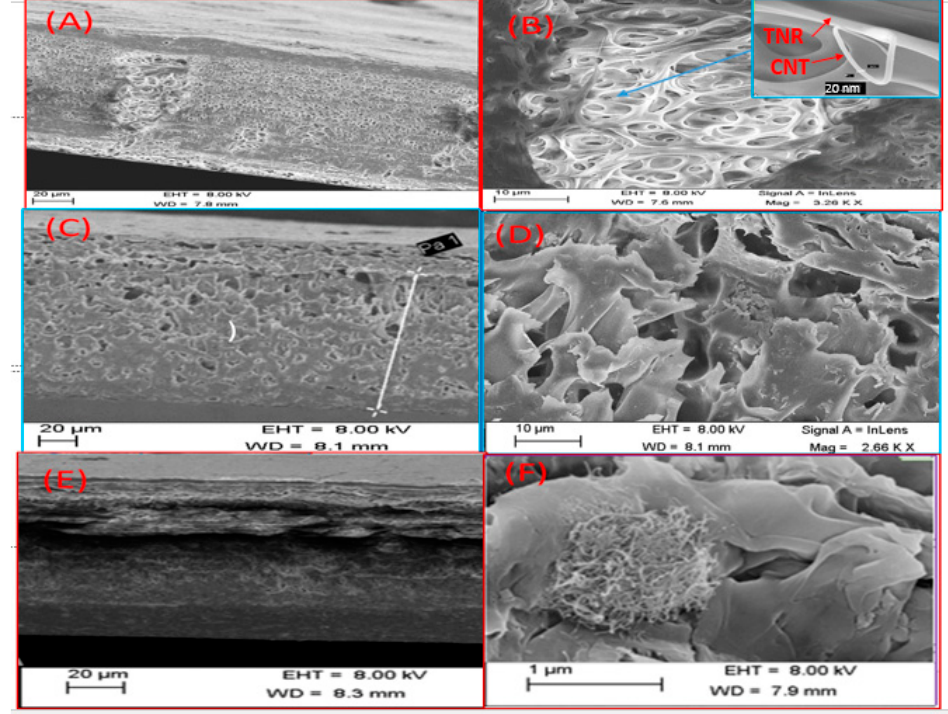
Figure 3. SEM images for ( A , B ) 0.1 PES/TNR-MWCNT, ( C , D ) 0.5 PES/TNR-MWCNT, and ( E , F ) 0.7 PES/TNR-MWCNT membranes.